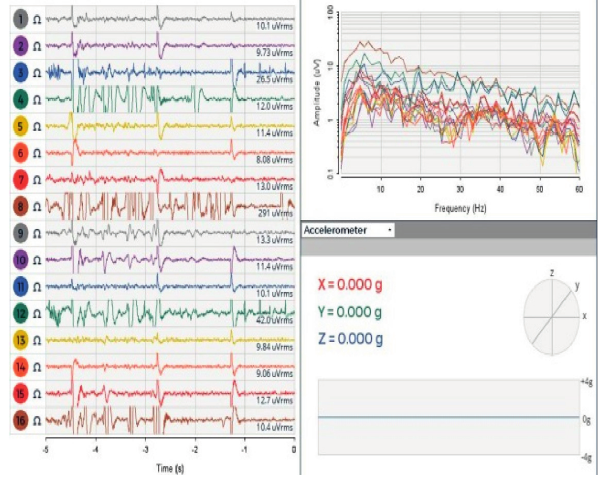
Figure 11: The EEG of knock action idea in the dynamic